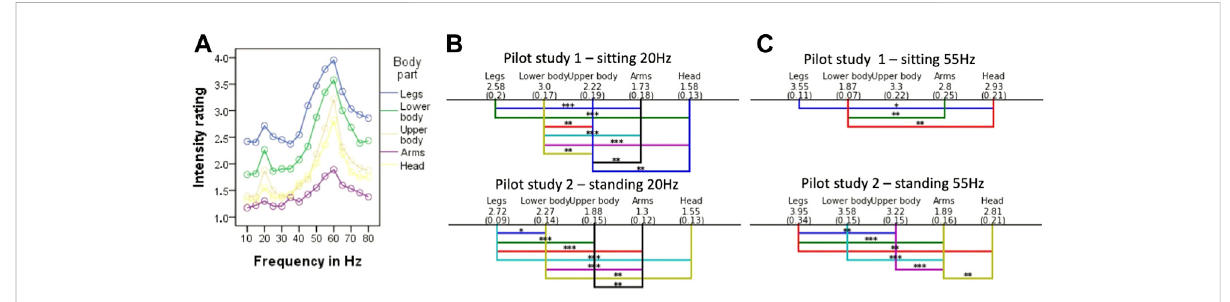
FIGURE 2 Pilot Study 1 (A) Perceived vibration intensity based on stimulus frequency, for foot condition. Right: Signi fi cance of identi fi ed peaks: Sitting (B) and standing (C) for representative frequencies (* < 0.05; ** < 0.01; *** < 0.001). The signi fi cance indicates clear differences in strengths of perceiving vibrationsinspeci fi cbodyparts.E.g.,inthestanding55 Hzconditionofpilotstudy2,theperceivedintensitywasverydifferentbetweenthearmsand the head. The differences are mainly associated with the point of